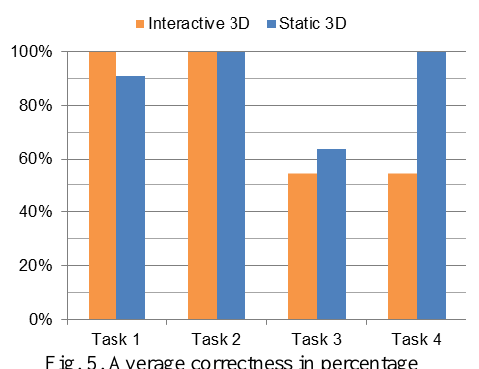
Fig. 5. Average correctness in percentage